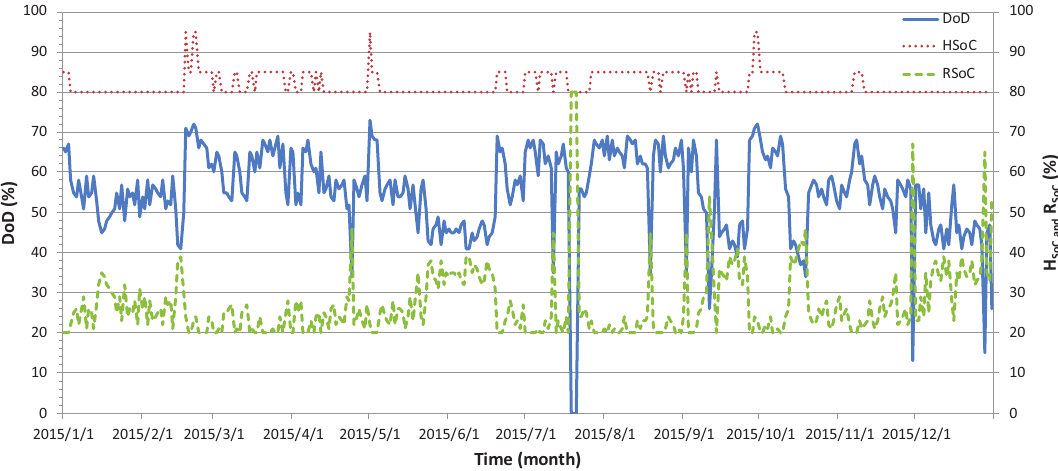
Figure 14. The DoD and recharge limit of SoC in one year